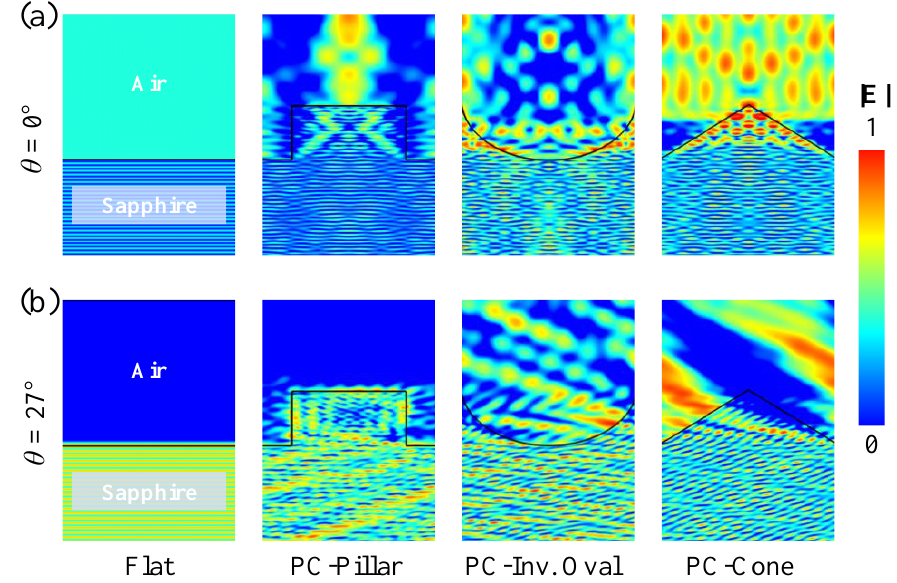
Figure 4. Normalized distributions of electric-field intensities for the related PC structures under two typical angles, i.e., θ = ( a ) 0° and ( b ) 27°.